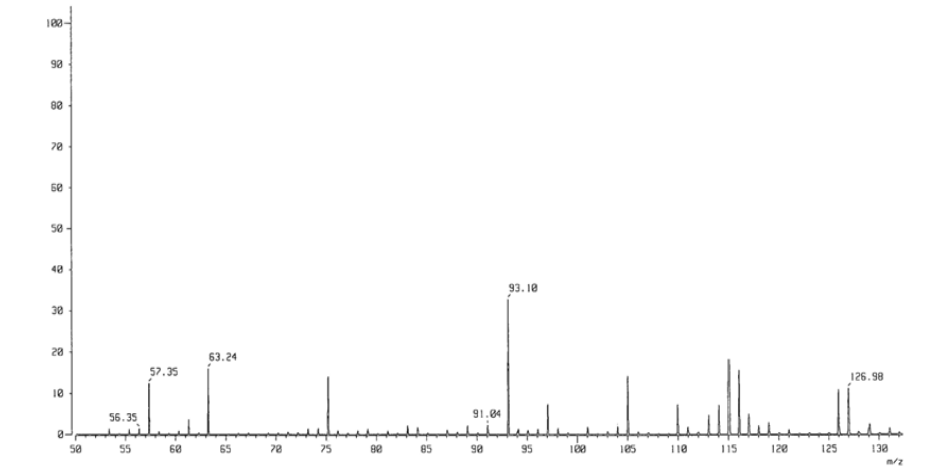
Fig. 3. FAB-MS of 2-aminoethansulfonic acid